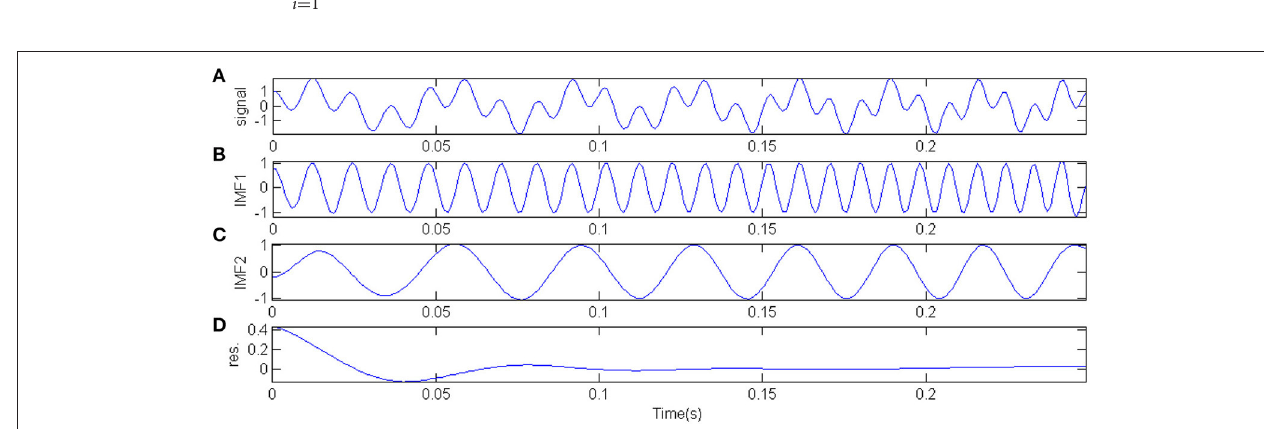
FIGURE 3 | EMD applied to the multi-component signal. (A) The simulated multi-component signal. (B) The first IMF(IMF1). (C) The second IMF(IMF2). (D) The residue.